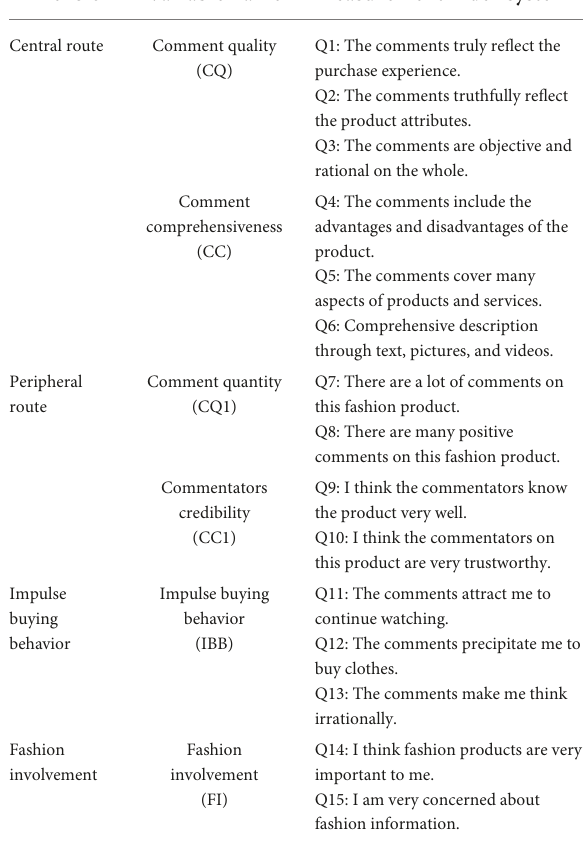
TABLE 1 Research measurement